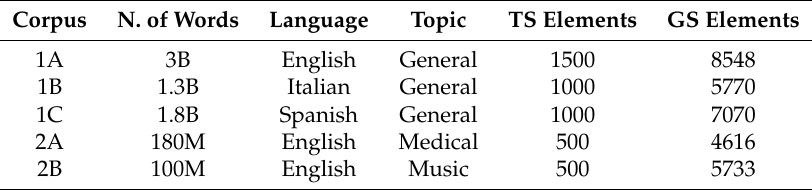
Table 1. Corpora information: here TS stands for Training set, while GS stands for gold standard.